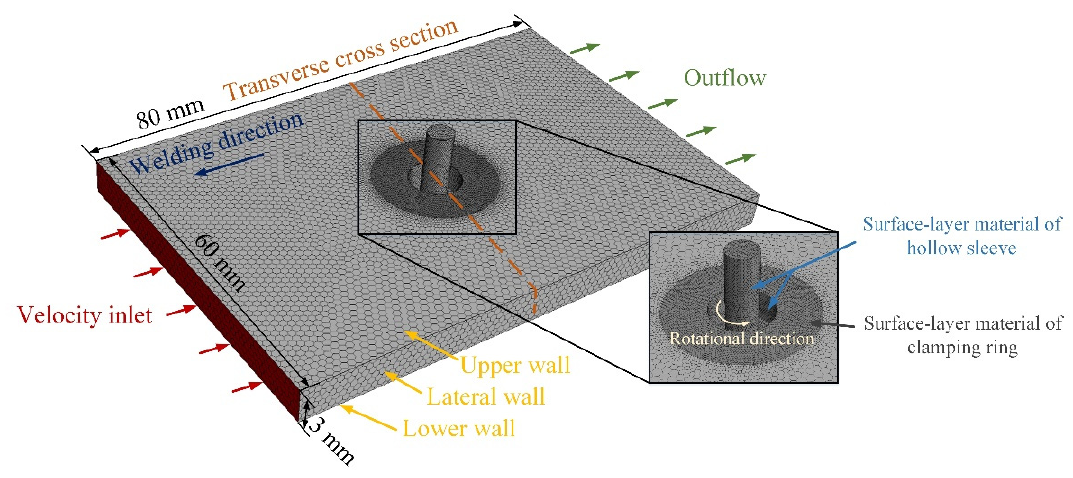
Figure 2. Mesh generation and boundary conditions used in the simulation.